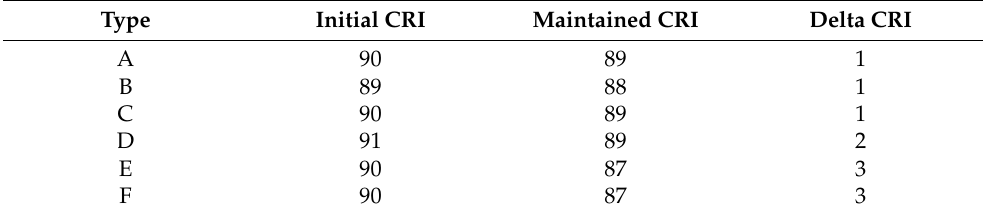
Table 6. Color rendering index (CRI) maintenance characteristics of OLED products with operating of six thousand hours.